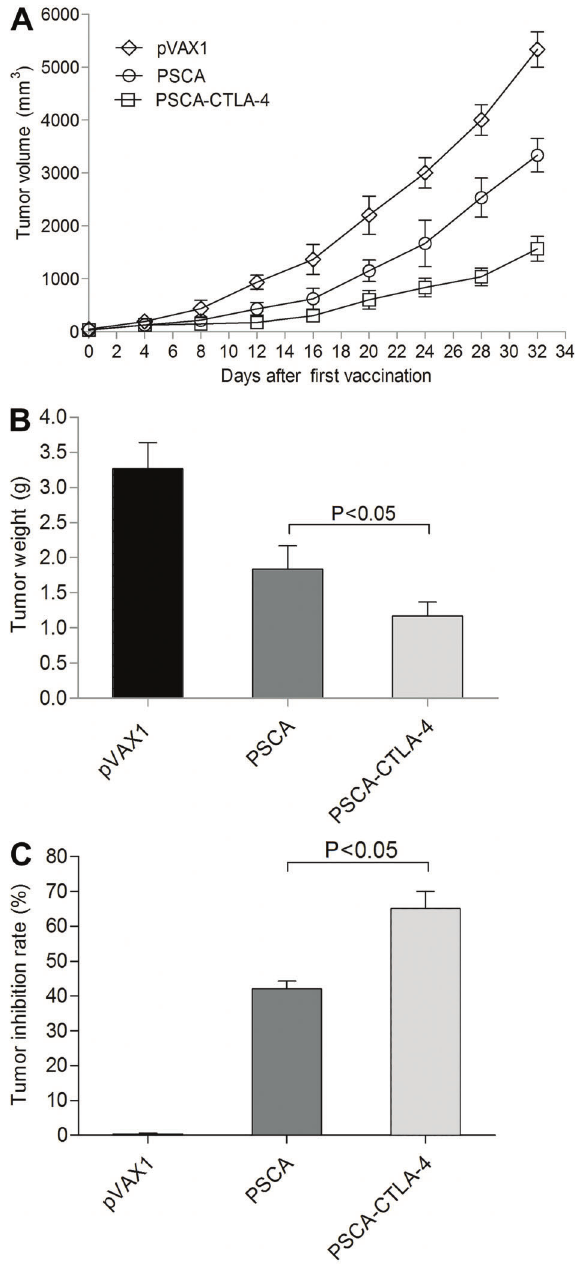
Figure 4. Anti-tumor ef fi cacy of DNA vaccines in a tumor bearing mouse model after immunization. The mice were subcutaneously inoculated with RM-1-PSCA cells (1.0 (cid:1) 10 5 ) in the right fl ank back. A , tumor growth curve; B , mean tumor weight; C, tumor growth inhibition rate. Data are reported as means ± SD